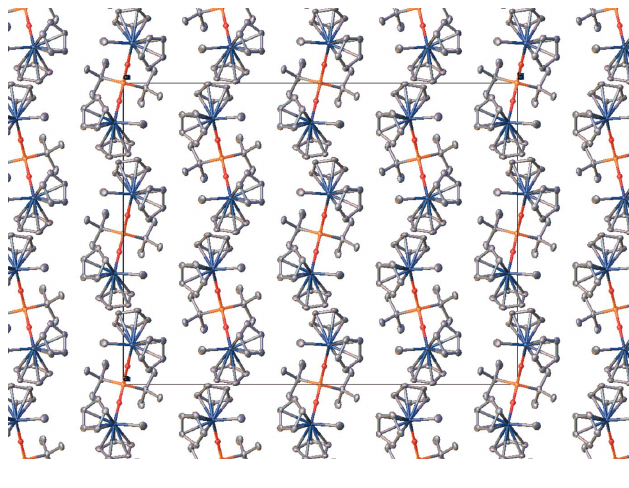
Figure 2 Packing diagram for one disorder partner of 1 , viewed down the c axis.